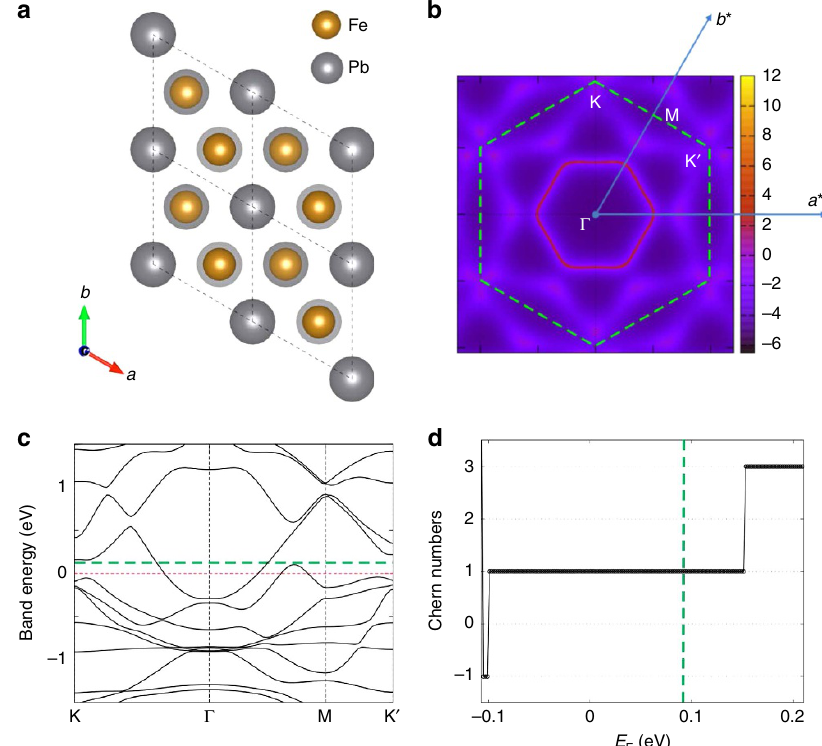
Figure 4 | Fe adatoms on Pb (111) surface. Electronic structure obtained from density-functional-theory (DFT) calculations. ( a ) The atomic configuration: Fe adatoms form a buckled a honeycomb lattice on the Pb (111) surface. ( b ) Fermi surface of the Fe d -orbitals at energy E F ¼ 0.09eV, where the Wigner– Seitz cell (dashed line) and the primitive vectors (arrowed lines) for the reciprocal lattice are indicated. A single Fermi surface is found around the G point in this case. ( c ) DFT band structure of the Fe d -orbitals with spin-orbit coupling. ( d ) Chern number of the Bogoliubov-de Gennes bands, as a function of Fermi energy, when s -wave superconductivity ( D ¼ 0.01eV in this calculation) is introduced in the system. The green dashed lines in both ( c ) and ( d ) mark the same energy corresponding to the Fermi surface given in ( b